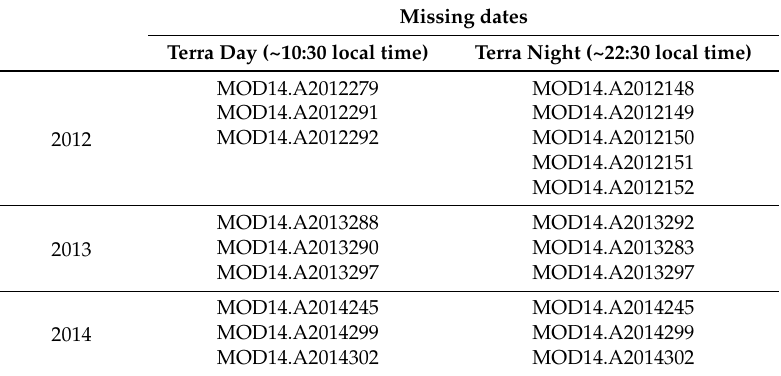
Table 1. Missing dates for the Terra MODIS land products from 2010 to